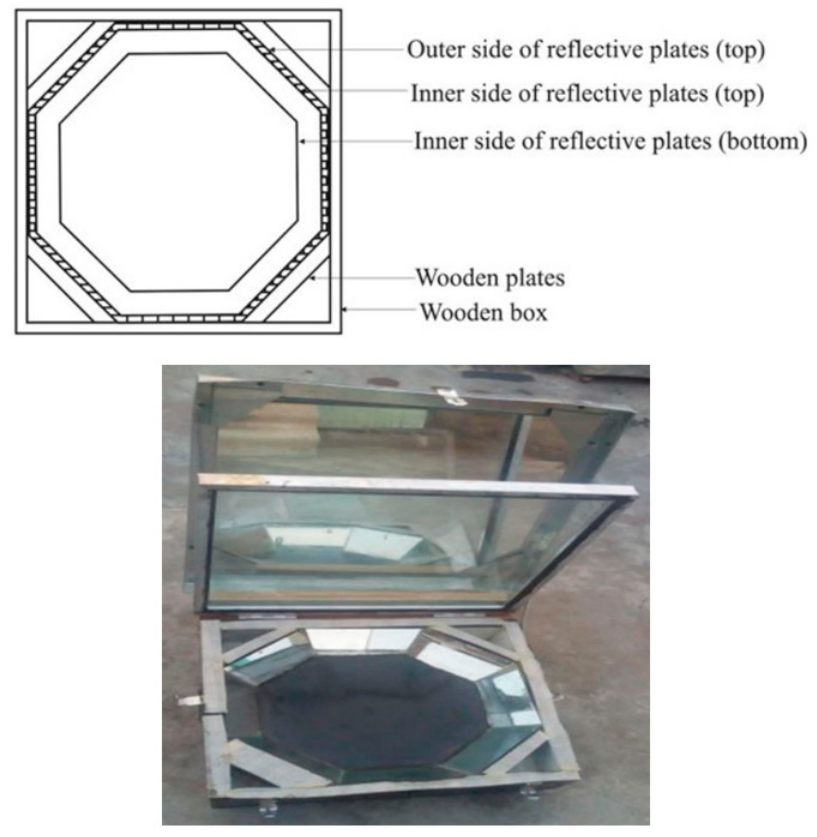
Figure 12. Schematic diagram and photograph of the solar cooker with Octagonal. Reprinted/adapted with permission from Ref. [40], 2019, Springer Nature.